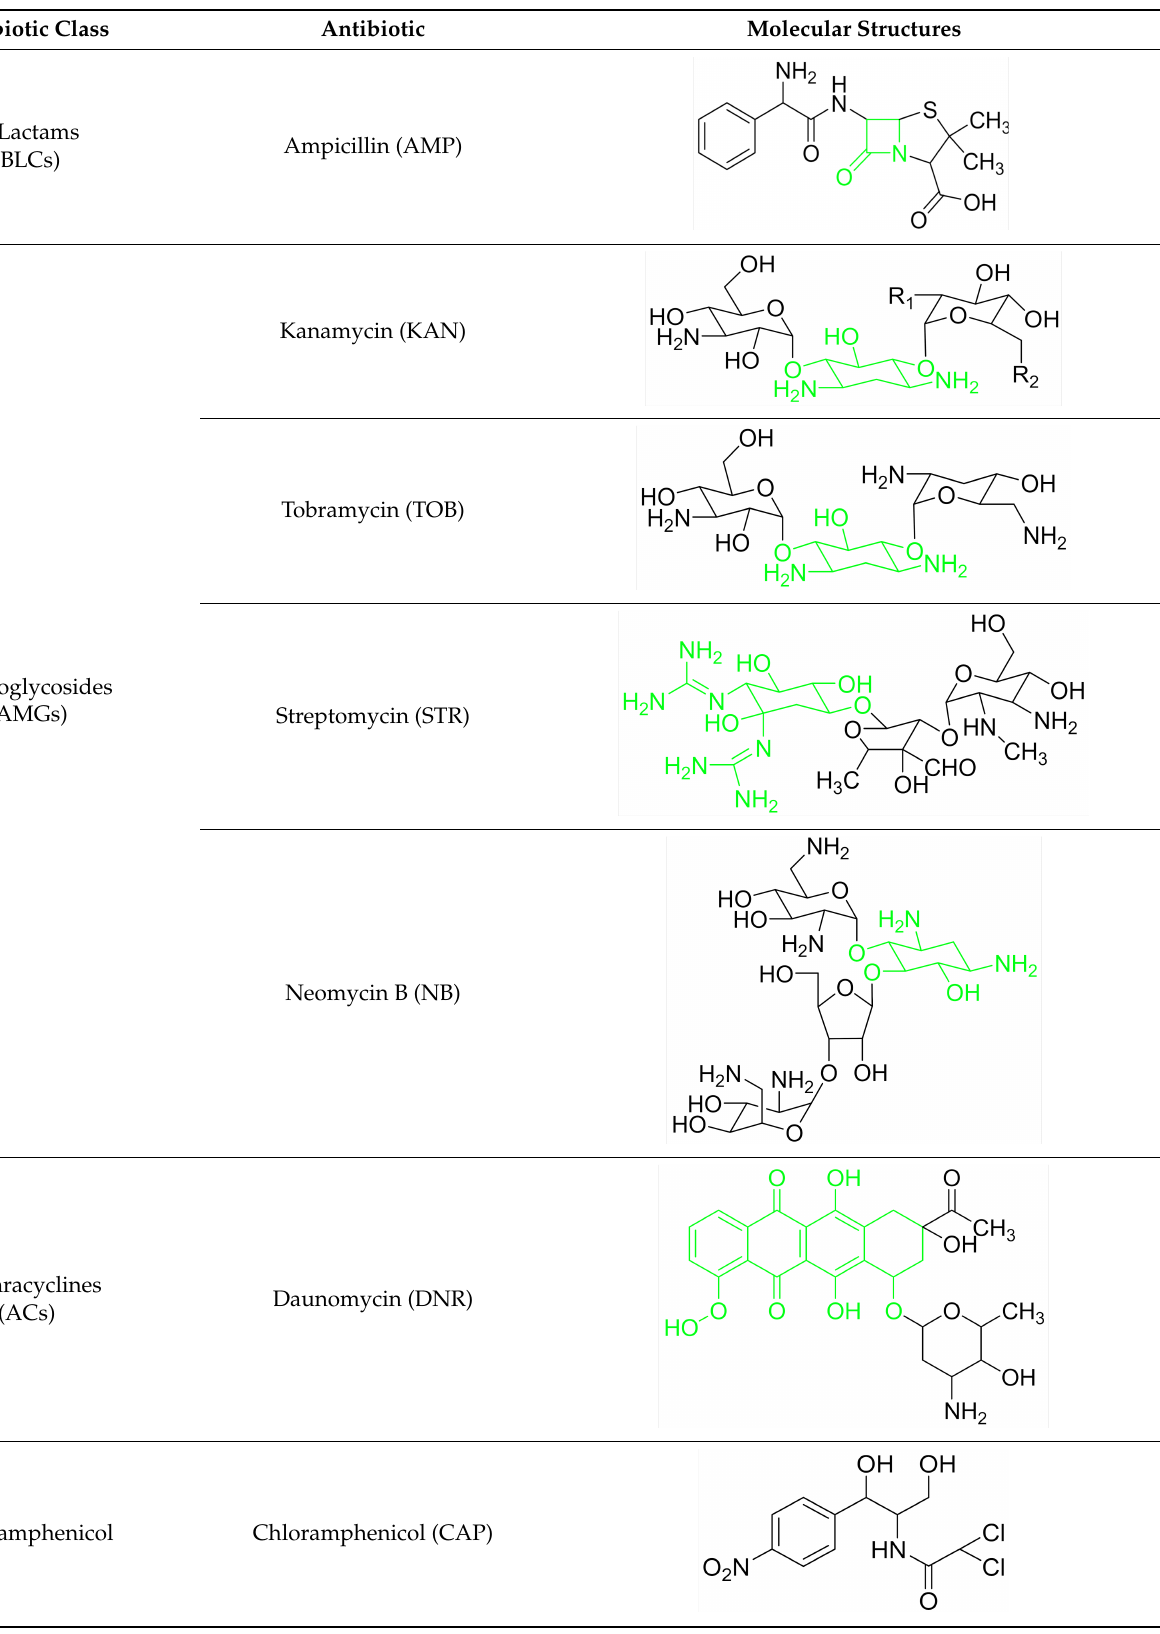
Table 1. Classification of seven antibiotic classes (basic structure highlighted in green), and their different derivatives (alterations from green to black molecular